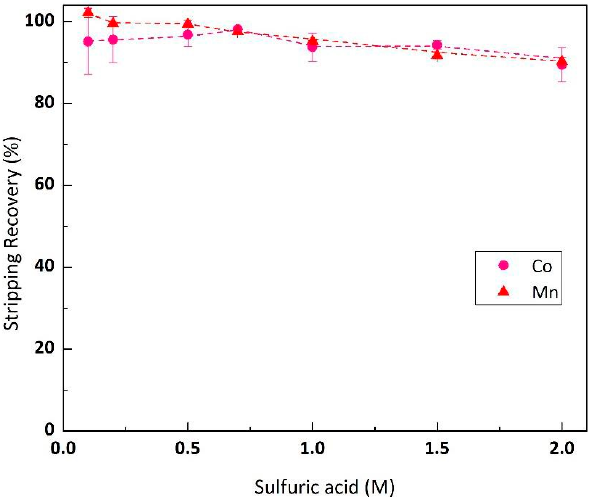
Figure 6. Effect of sulfuric acid concentration on Co-Mn stripping rate from loaded organic (O/A